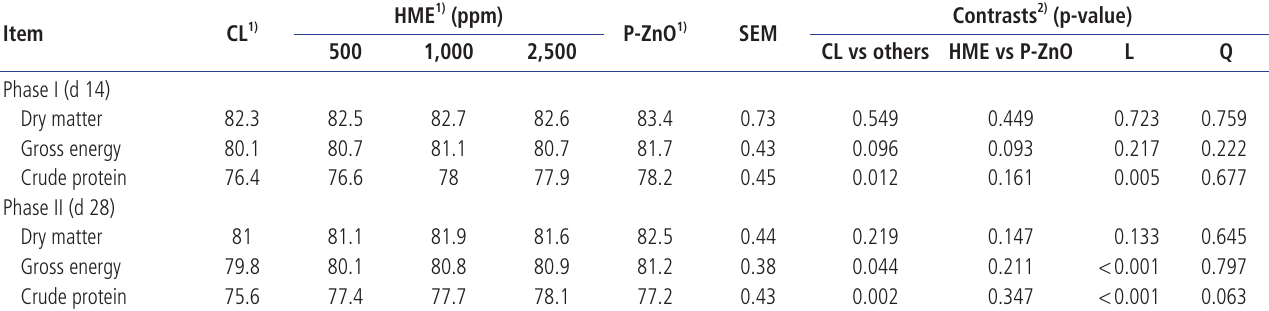
Table 3. Effects of different ZnO sources on apparent total tract digestibility (%) of nutrients in weanling pigs Item